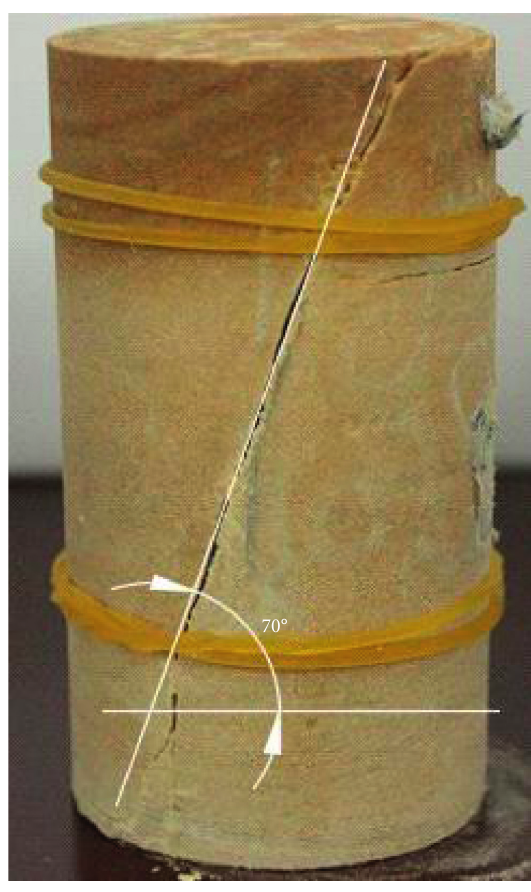
Figure 18: Rock fracture shape and angle of sample 10–5.